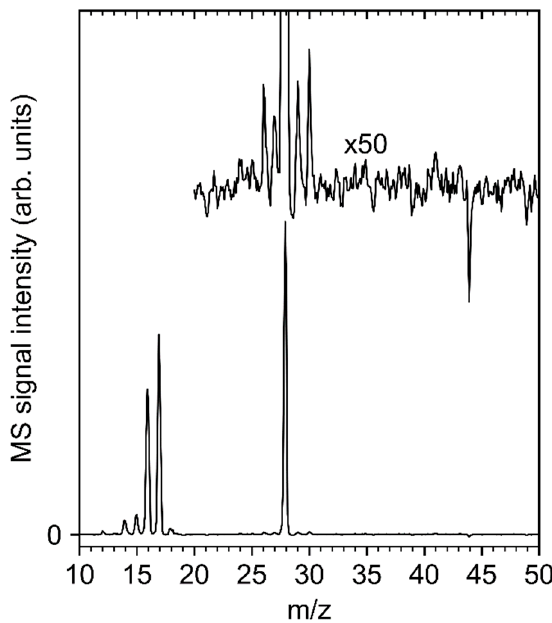
Figure 4. Mass spectrum ( m / z 10 − 50) of the volatile species produced upon ESD ( E 0 = 31 eV) of an NH 3 film condensed on top of a model deposit fabricated by electron irradiation ( E 0 = 31 eV, 40 mC / cm 2 ) from 7 to 0 ML (EtCp) 2 Ru on a Ta substrate held at 110 K and subsequent annealing (450 K). The spectrum represents an average of three mass scans obtained at the start of irradiation with the ultrahigh vacuum (UHV) chamber background signals subtracted.